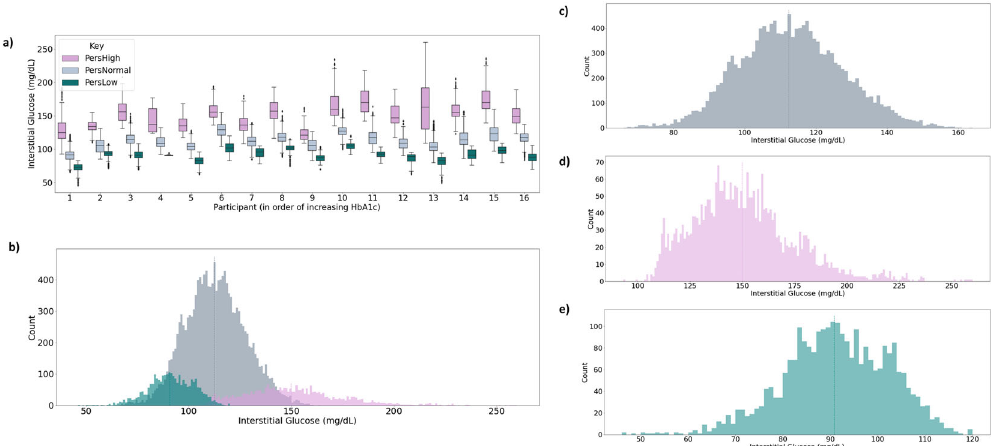
Fig. 3 Personalized glucose excursions. Glucose excursions are classi fi ed on a personalized, rolling basis examining the previous 24 h of each participant ’ s historical data. a Boxplots of PersNorm, PersHigh, and PersLow for each participant in the dataset. b Histogram of all distributions over all participants. c PersNorm distribution. d PersHigh distribution. e PerLow distribution. Bin width for each histogram shown is 1